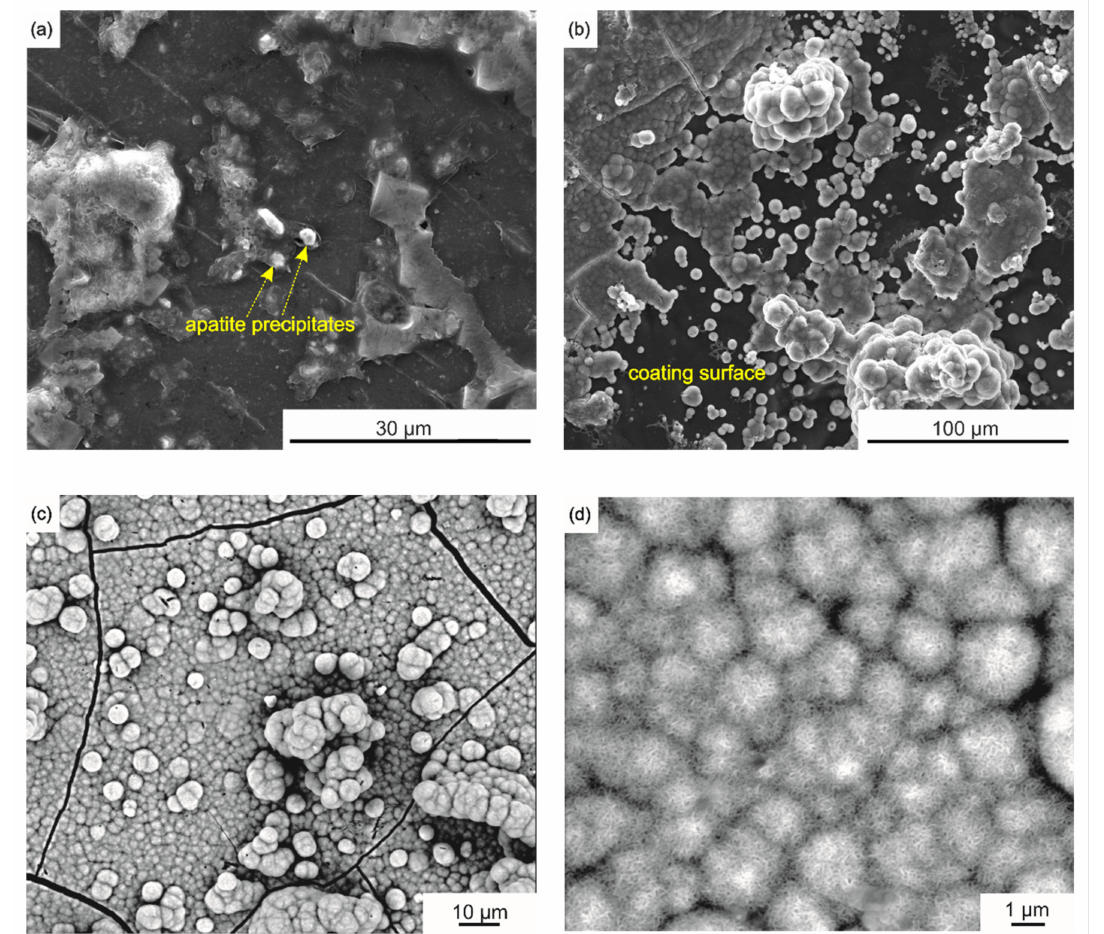
Figure 17. SEM images of the coated zirconium alloy after incubation in the SBF for 7 days ( a ), 10 days ( b ) and 21 days ( c , d ). ( c ) shows cauliflower-like morphology, while ( d ) shows flake-like morphology of the apatite